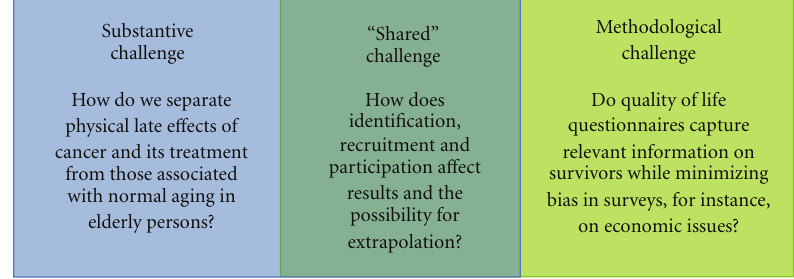
Figure 1: An example of a substantive, a methodological, and a “shared” challenge.